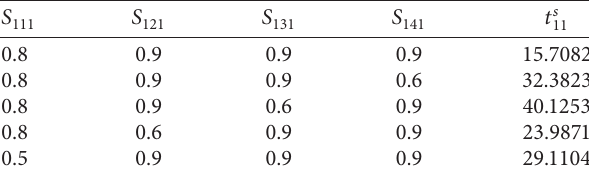
Table 7: The influence of required knowledge on execution time.